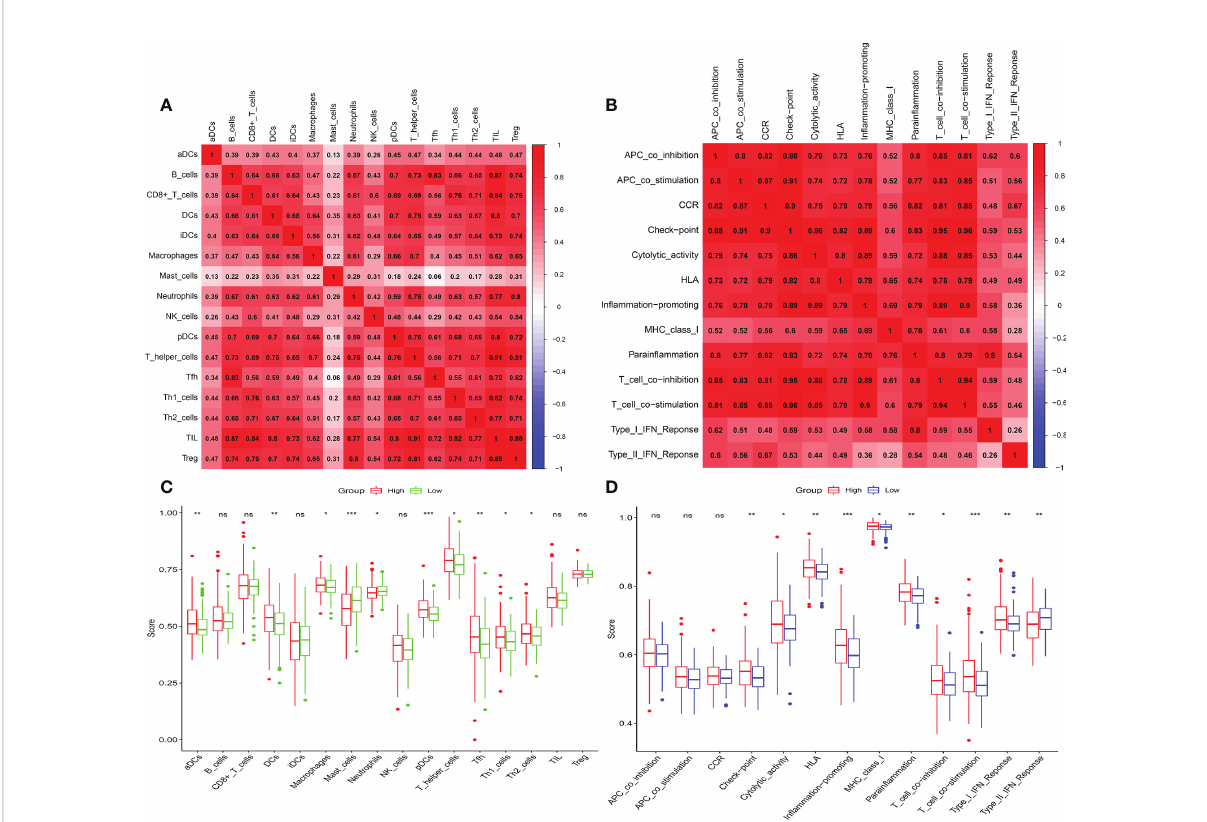
FIGURE 10 Immune in fi ltrating and correlation analysis. (A) Correlation between different immune cells. (B) Correlation between different immune-related pathways. (C, D) Analysis of enrichment scores of immune cells and immune-related pathways. (ns, p >= 0.05; *0.01 <= p < 0.05; **0.001 <= p < 0.01; ***p <